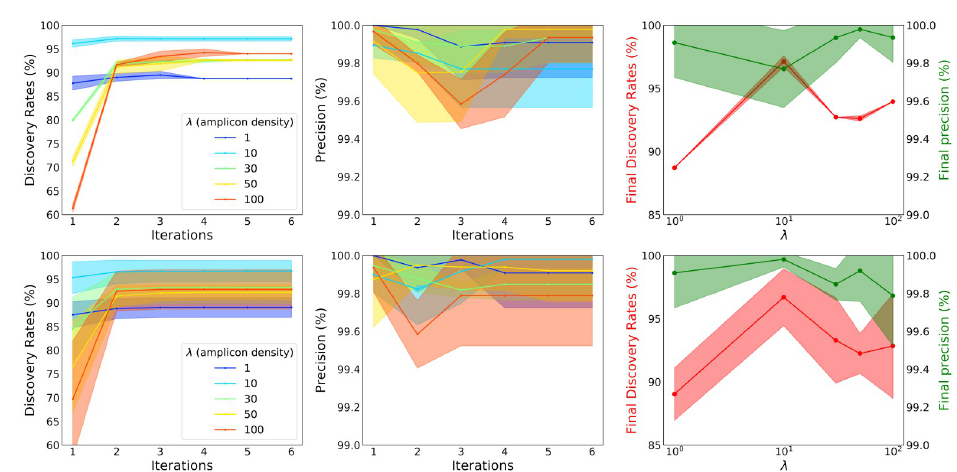
Fig 5. An iterative non-negative matrix factorization approach enables barcode discovery in the high-amplicon- density regime for high-resolution, dense-expression simulations. Top : five datasets are randomly simulated from a single EM volume and performances are summarized here. The left panel shows barcode discovery rate, as a fraction of the 975 neurons present in the original EM volume. The middle panel shows the precision at each iteration, which is the proportion of True Positives among all the positive detections. These two panels show these metrics evaluated on STIBEs with various densities of amplicons ( λ , colored lines) analyzed using different numbers of iterations. The shaded regions for each line indicate the standard deviation. We see that multiple iterations improve recovery accuracy when the density of amplicons is high. The right panel shows the final discovery rate (vertical axis on the left, red) as well as the final precision (vertical axis on the right, green) after six iterations, as a function of amplicon density (at log- scale, horizontal axis). Recovery accuracy peaks at λ values around 10 amplicons/ μ m 3 , where amplicons are neither too dense (where too much optical overlap leads to decreases in recovery accuracy) nor too sparse (where there is simply not enough information to recover some barcode identities). Bottom : five datasets are randomly simulated from five different EM volumes and the performances are summarized here. The plots are arranged in the same way as above. Here we see a very similar trends, albeit with larger variations across the replicates, confirming the results generalize across multiple FOVs. These plots further confirmed that 10 amplicons/ μ m 3 is an optimal value for this iterative barcode discovery task, under these simulated imaging